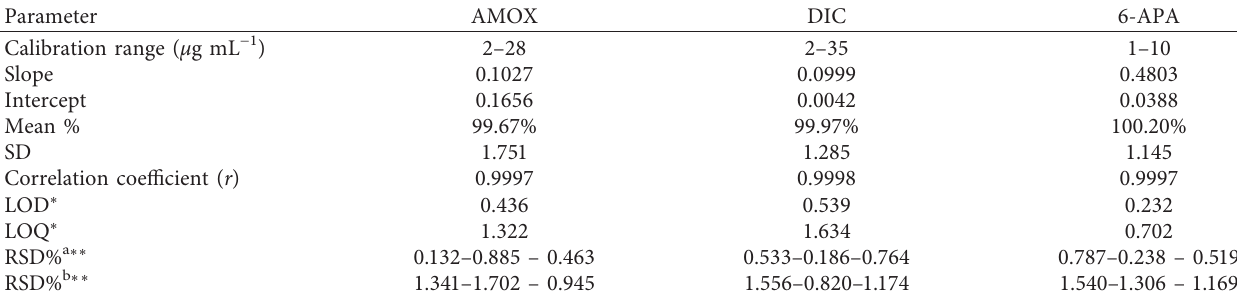
Figure 2: HPLC/MS chromatogram of resolved mixture of 20 µ g mL − 1 of AMOX, 10 µ g mL − 1 of 6-APA, and 20 µ g mL − 1 of DIC ( R 2.538, and 3.503min, respectively) using (acetonitrile:water (65:35 by volume) as mobile Table 1: Validation analytical parameters of the developed HPLC/MS method for the simultaneous assessment of AMOX, DIC, and 6-APA. Parameter